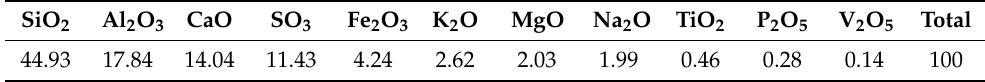
Table 1. Chemical composition analysis of the raw coal gangue